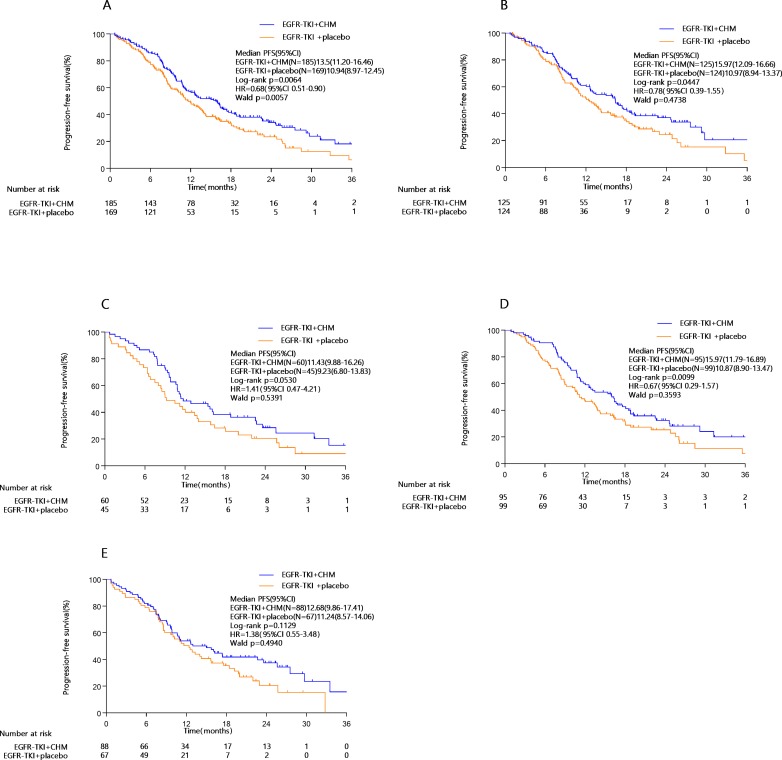
PFS in the (A) intent-to-treat population, (B) first-line EGFR-TKI subgroup, (C) second-line EGFR-TKI subgroup, (D) exon 19 deletion subgroup, (E) 21 L858R point mutation subgroup; PFS, progression-free survival; EGFR-TKI, epidermal growth factor receptor tyrosine kinase inhibitors.